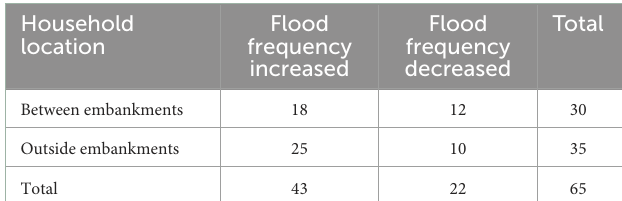
TABLE 4 Household responses on flood frequency in post embankment